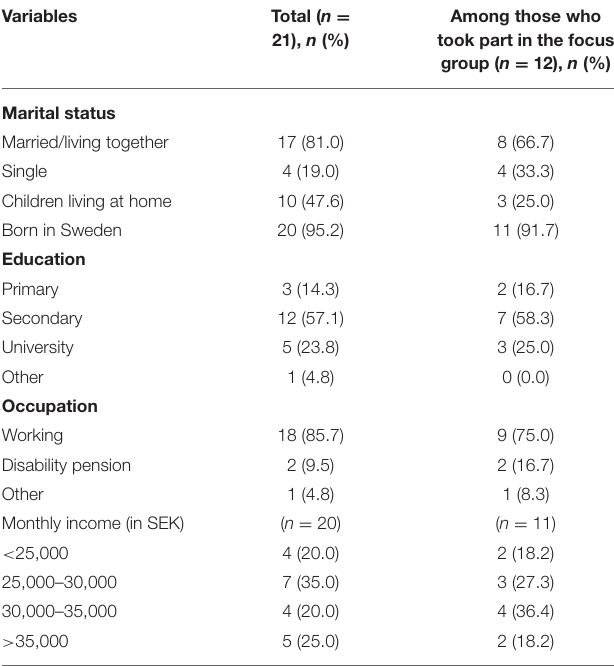
TABLE 2 | Baseline characteristics of all participants from the second term and those who took part in the focus group.